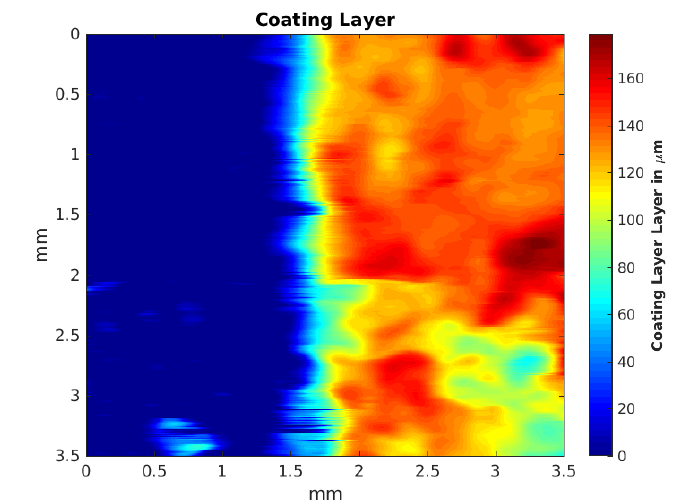
Figure 6. 3D heat map of the calculated coating layer thickness for the OCT measurement of the customized sample (sample 7).